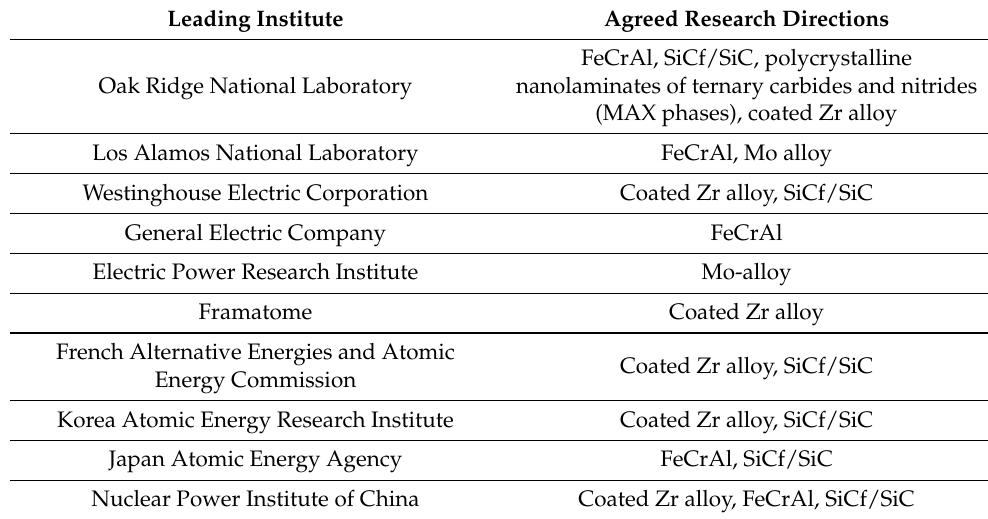
Table 1. Leading institutes and their options on ATF claddings.